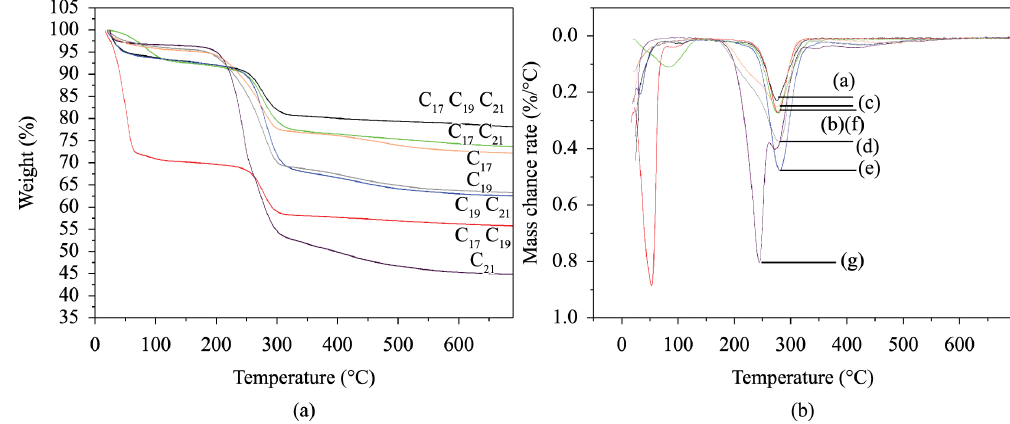
Figure 6. TG (a) and DTG (b) profiles of C